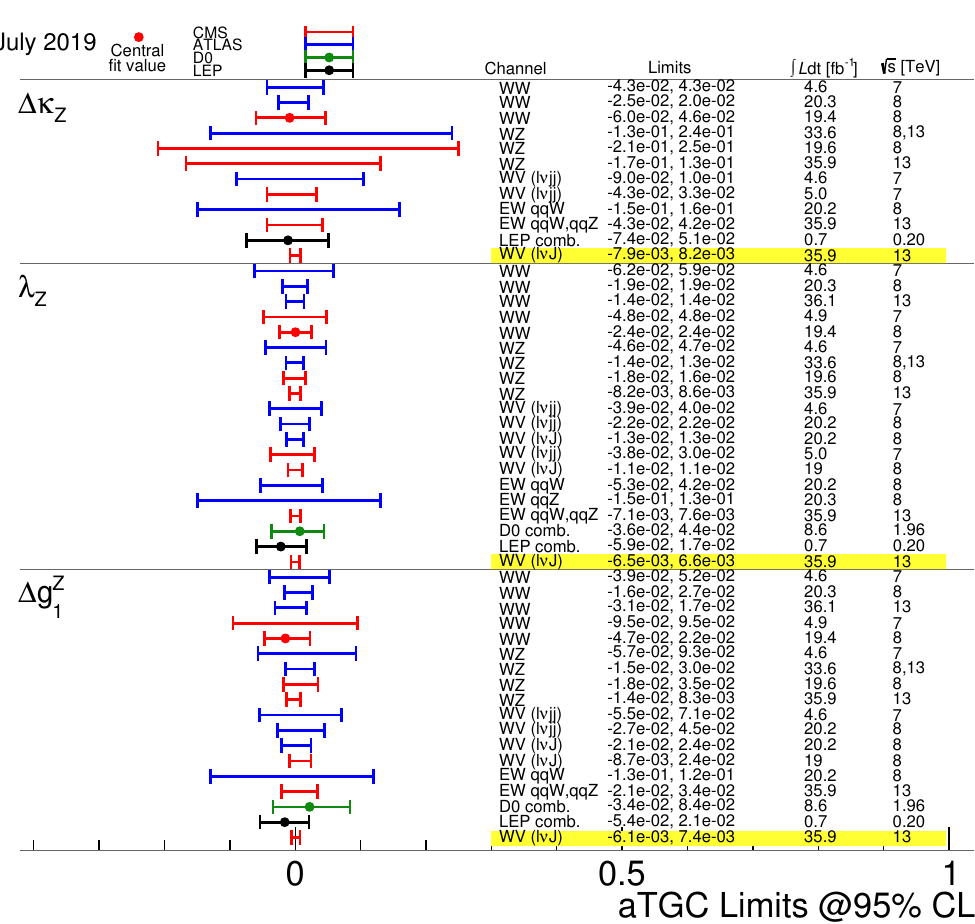
and (cid:1) (cid:20) , respectively, using the relationships Z Z